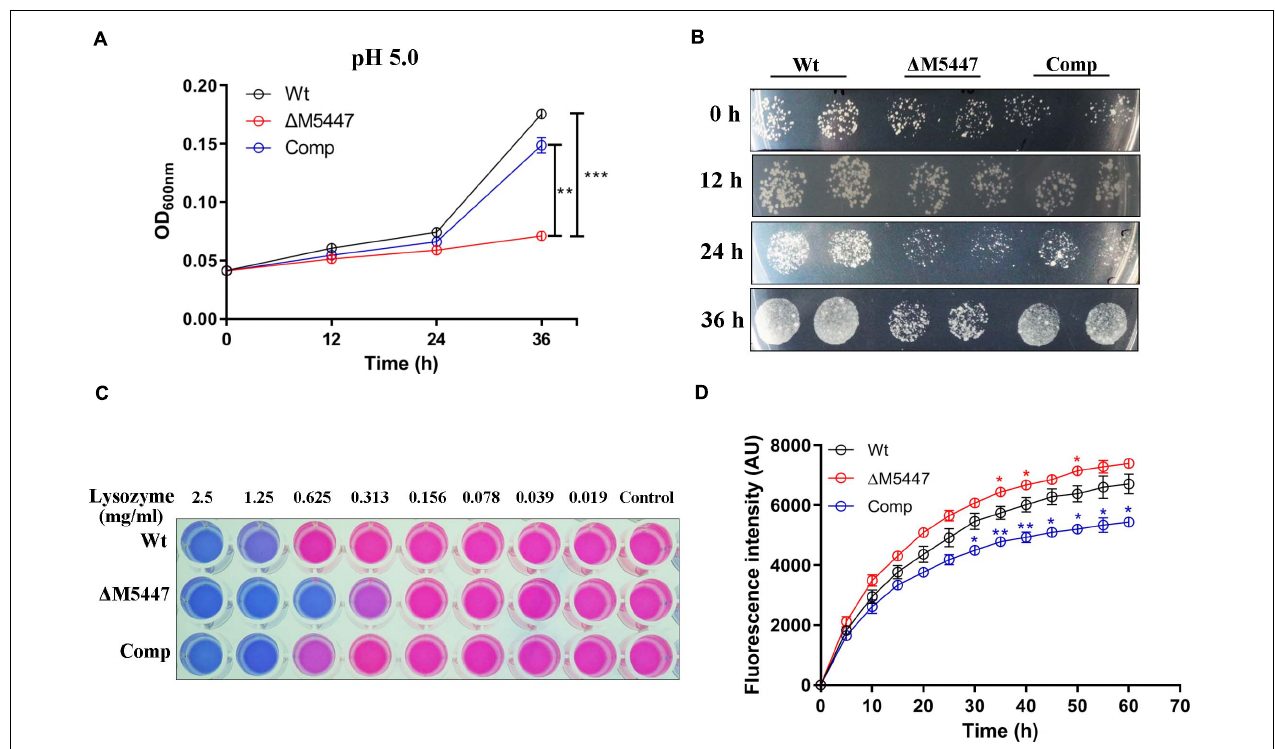
FIGURE 3 | The tolerance of (cid:49) M5447 to lysosome-related stress was reduced. (A) Wt, (cid:49) M5447, and Comp strains were cultured in LBT acidic medium (pH 5.0); the growth of bacteria was determined by measuring OD 600 at an interval of 12 h. (B) The corresponding cultures from acidic medium were plated on LB agar plates with a 100-fold dilution at an interval of 12 h. (C) Wt, (cid:49) M5447, and Comp strains were treated with lysozyme in a two-fold serial dilution for 24 h. Resazurin dye was added and incubated for 5–12 h for color development. The changed color from original blue to pink indicated that the living cells existed. The well contained bacterial culture only as control. A representative result was shown from three independent experiments. (D) Mid-log phage cultures of Wt, (cid:49) M5447, and Comp strains were incubated in PBST with 2 µ g/ml EB. The EB accumulation of strains was observed for 1 h at an interval of 5 min. The value at each point is normalized to the time of zero value. Data were shown as mean ± SD of triplicate wells. Statistical analyses were performed by the method of two-way ANOVA (* p < 0.05, ** p < 0.01, *** p <